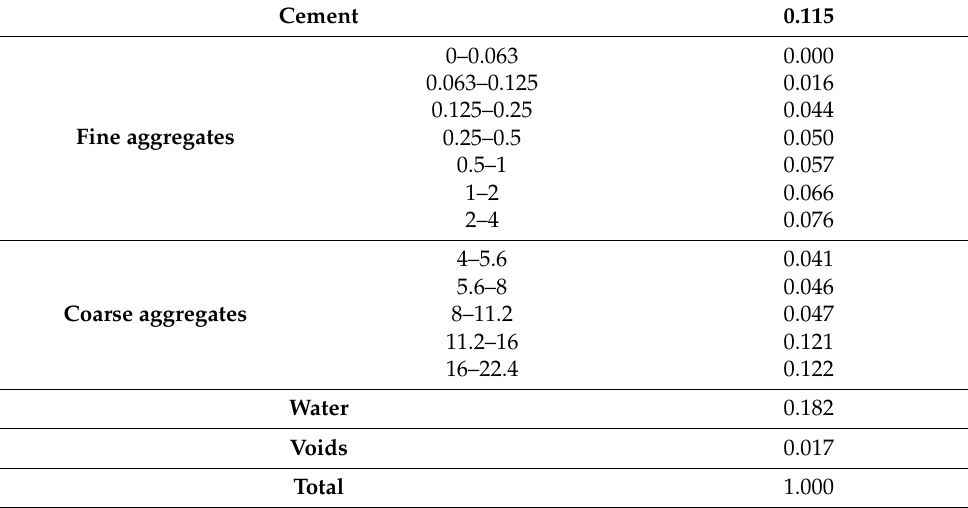
Table 5. Composition of the reference concrete (RC)